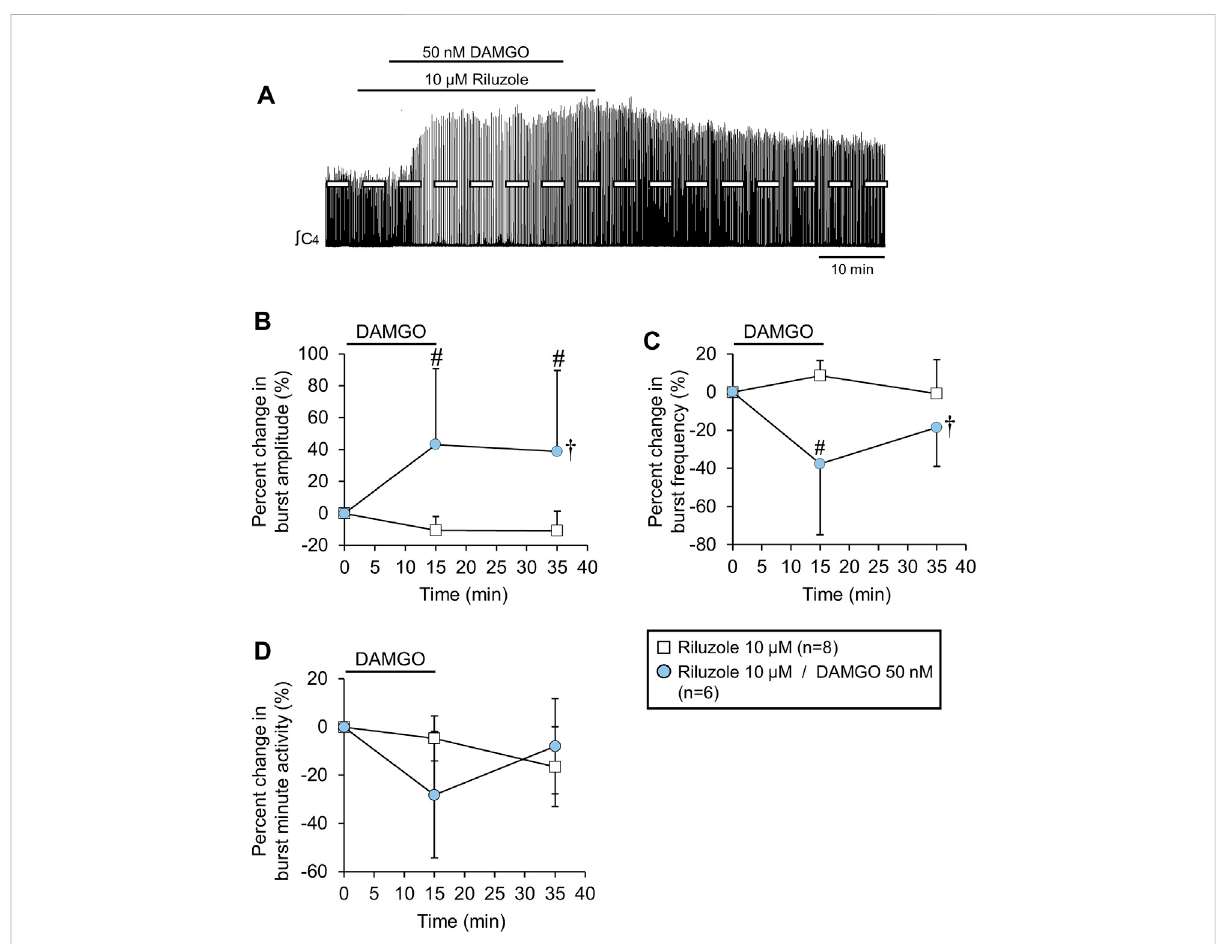
The DAMGO-induced burst amplitude increase was not altered by riluzole. (A) Voltage trace showing that DAMGO increased burst amplitude and decreased burst frequency during a backgroundriluzole application. (B) Burst amplitude increased and (C) burstfrequency decreased, while (D) minute activity was not altered (blue circles) compared to riluzole time controls (white squares). The pound sign (#) indicates a signi fi cant pairwise comparisondifferencefromtimecontrolsatthattimepoint,andthedagger( † )indicatesasigni fi cantoverallDAMGOconcentrationeffect.Data shown as mean ± SD. These data suggest that the DAMGO-induced burst amplitude increase was not related to gasping since riluzole blocks persistent sodium currents associated with